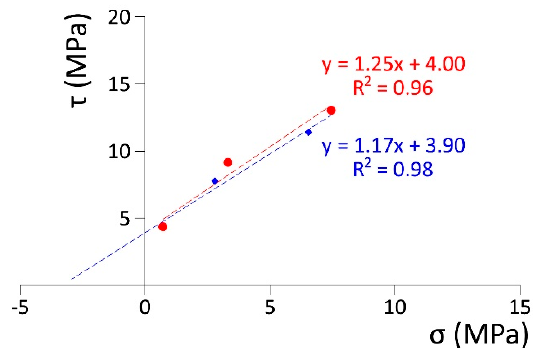
Figure 6. Experimental data points from Table 5 presented in σ – τ space with linear fit to determine cohesion from the Mohr–Coulomb model.